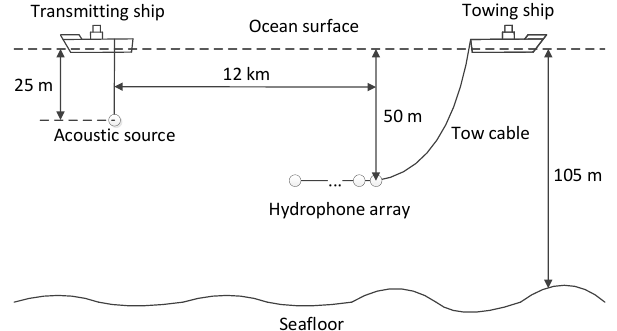
Figure 7. Schematic diagram of the sea